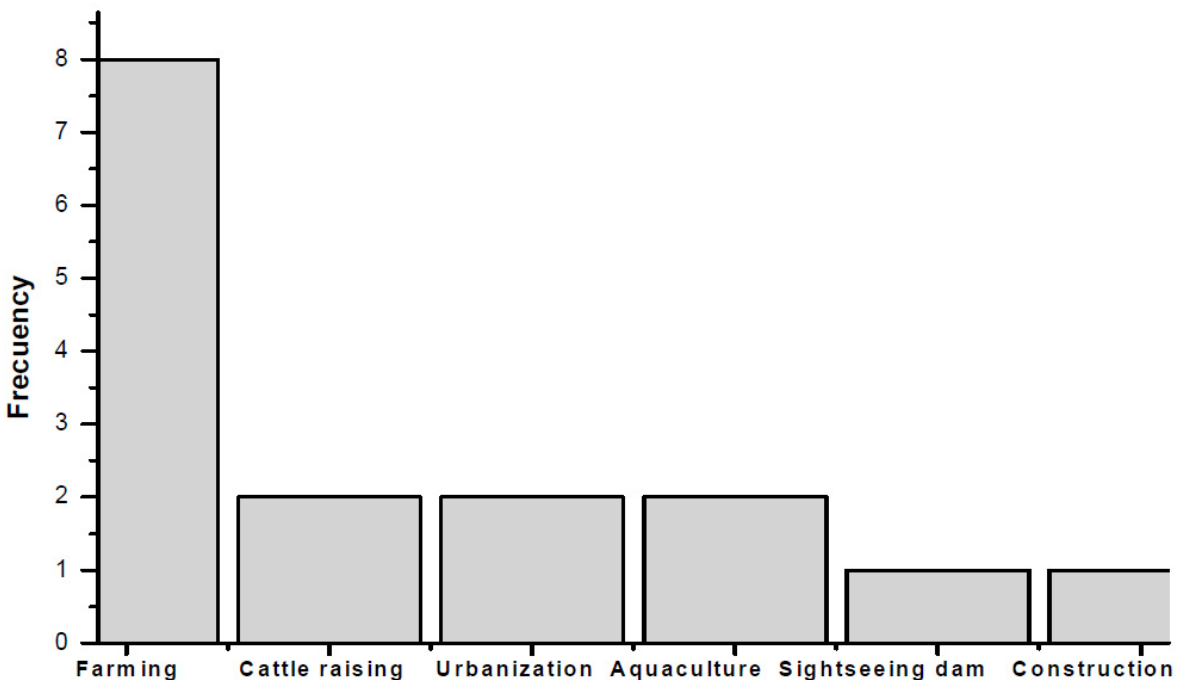
Figure 9. Frequency distribution of incident factors in Europe.